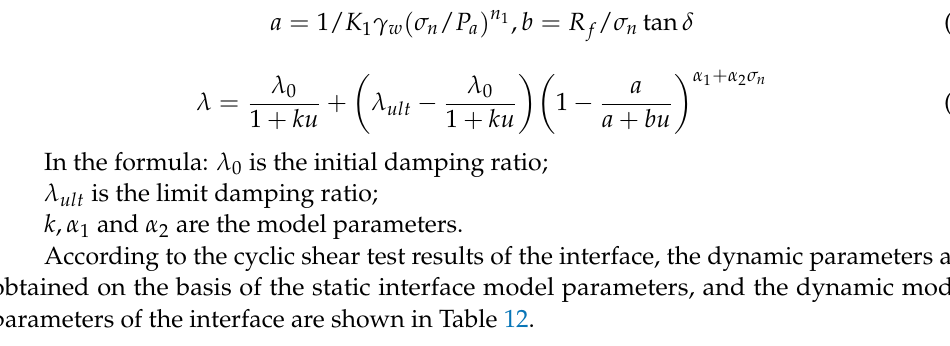
Table 12. Dynamic model parameters of polymer–soil